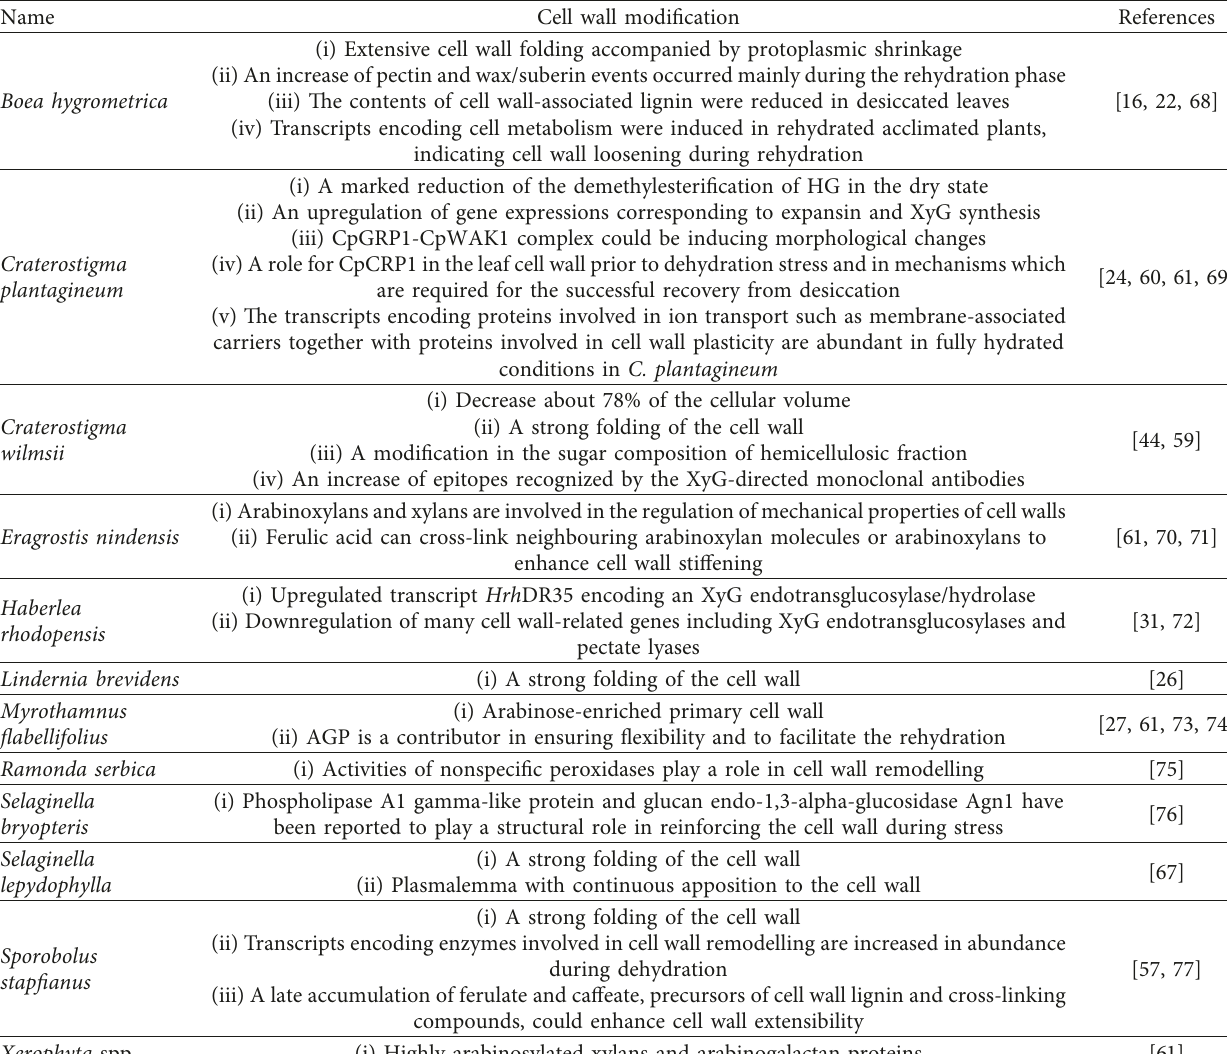
Table 2: Cell wall modifications of DT